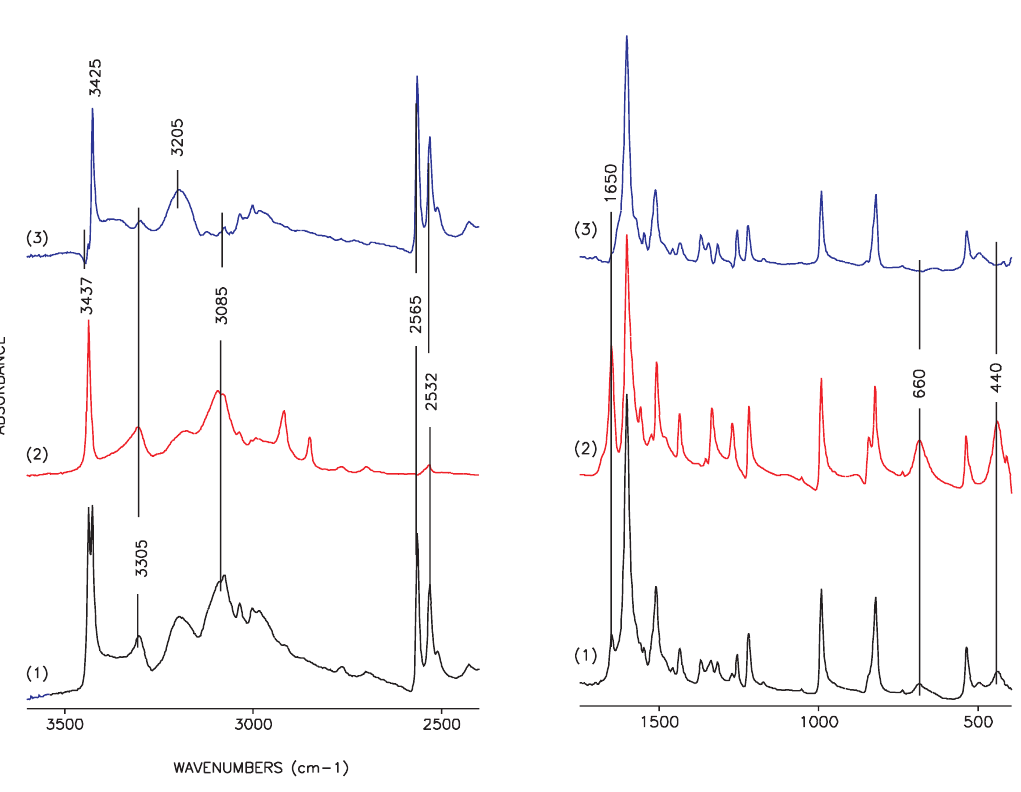
Fig. 4 Solid state spectra of a mixture of 4-AP and 4-AP deutero derivarive (1); the correspond- ing reduced spectra after elimination of the bands at 2565 cm − 1 (2) and 3437 cm − 1